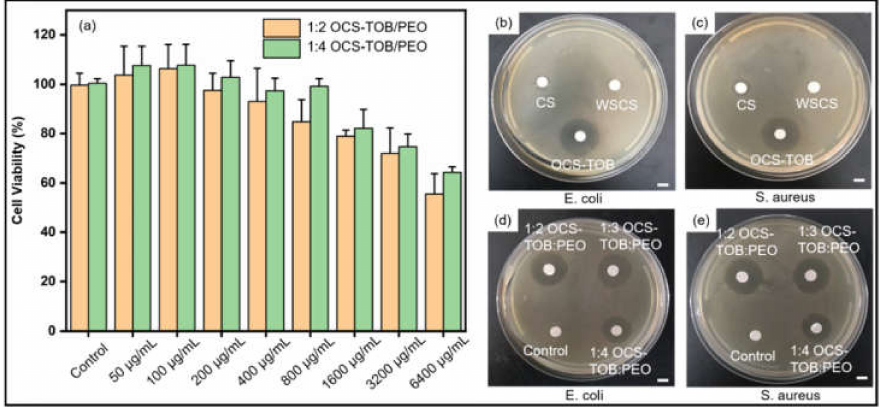
Figure 4. Cell viability of 1:2 OCS-TOB/PEO and 1:4 OCS-TOB/PEO in 24 h ( a ); inhibition effect of CS, WSCS and OCS-TOB against E. coli ( b ) and S. aureus ( c ); and inhibition effect of different ratios of OCS-TOB/PEO sub micro-fibers against E. coli ( d ) and S. aureus ( e ). Scale bar is 5